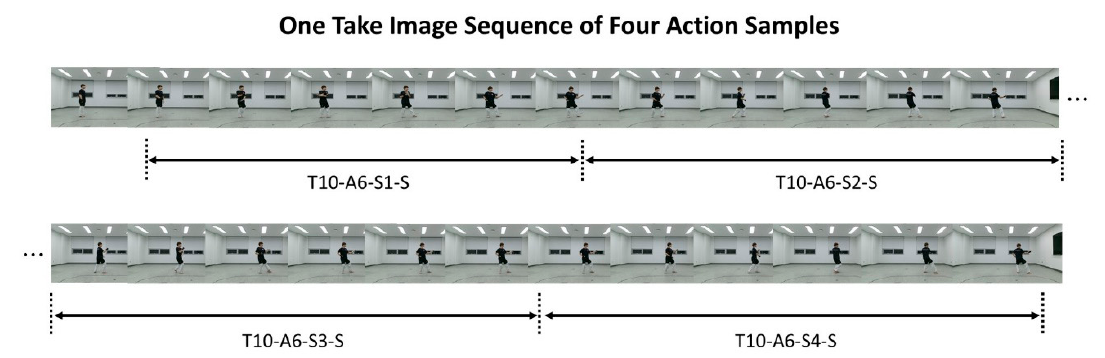
Figure 7. Data organization process: take image sequence including four action samples. The start and